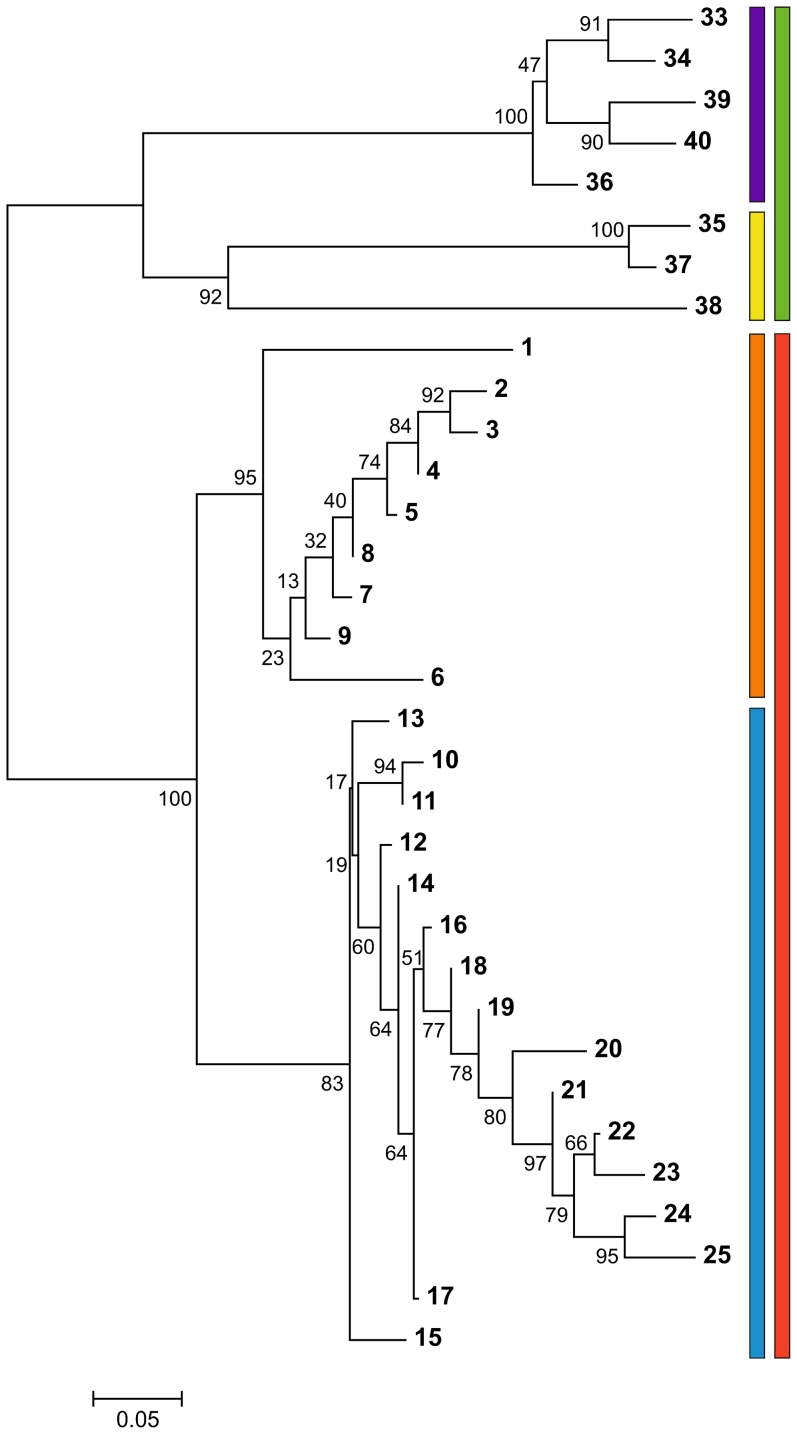
Relationships among populations.A neighbor-joining tree was constructed from the matrix of pairwise F
ST; syntopic populations were excluded. Robustness of relationships was tested with 1000 bootstrap replicates. Red – L. montandoni: orange – northern, blue – southern group; green – L. vulgaris: yellow – populations in the Carpathian Basin, violet – populations outside the Carpathian Basin.